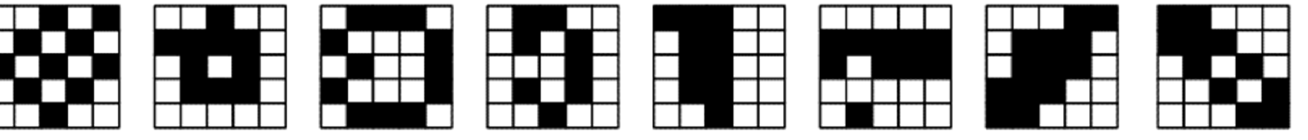
Figure 11. Randomly generated noisy pa tt erns.